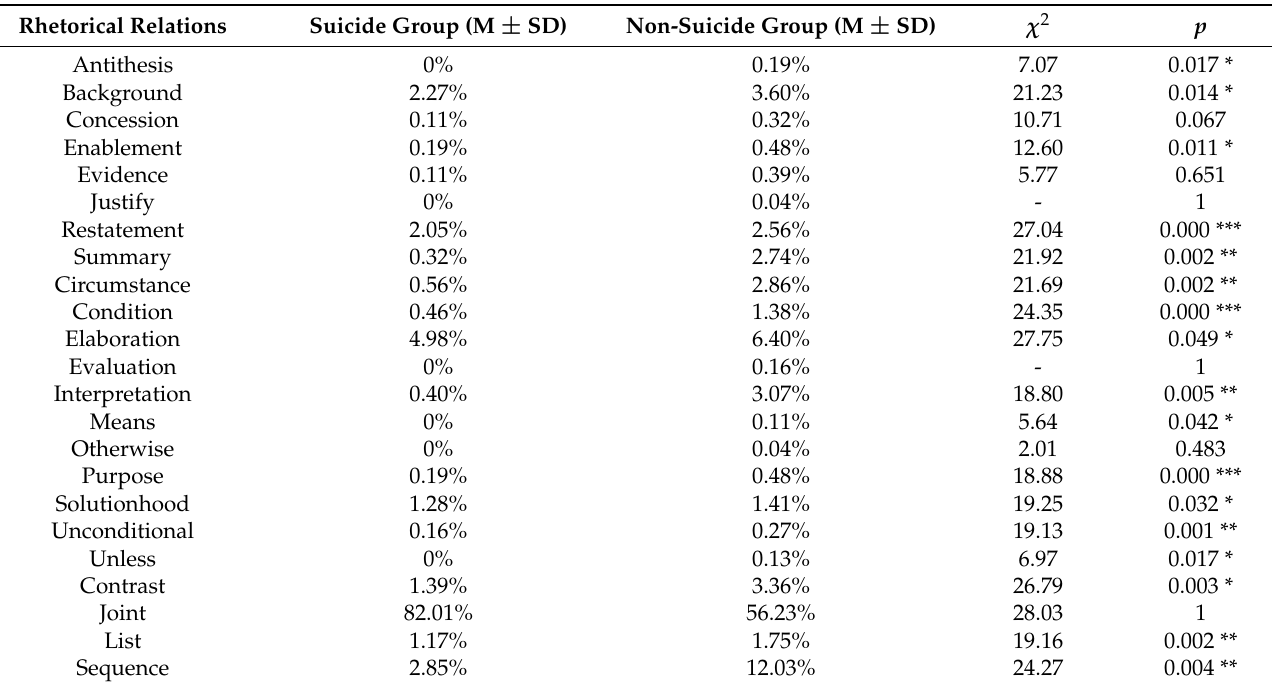
Table 3. Rhetorical relation proportions of participants by suicidal